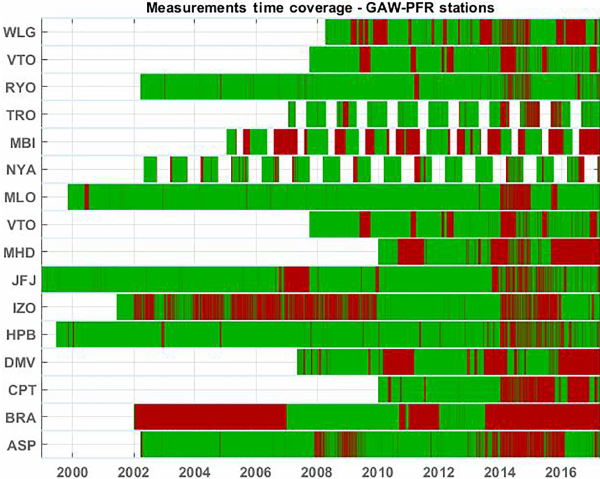
Figure 4. Data coverage of GAW-PFR stations. Green indicates pe- riods with data availability and red indicates missing